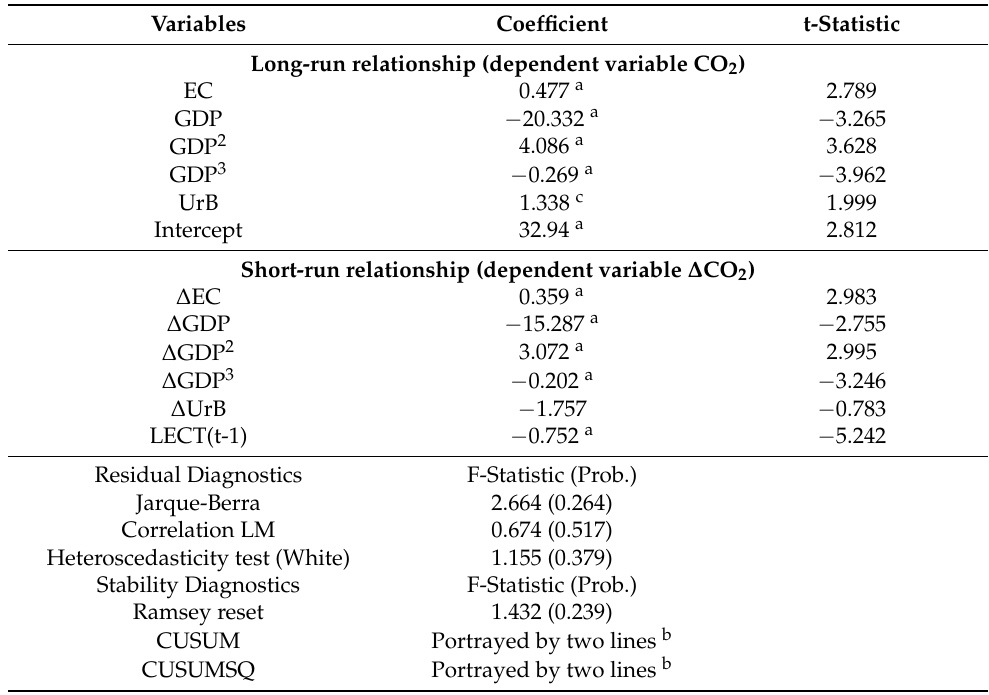
Table 5. Long run and short run